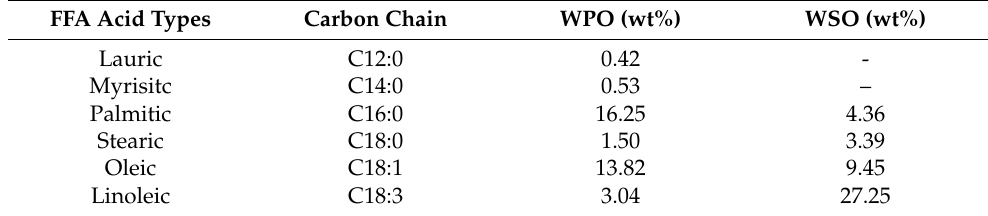
Table 3. Fatty Acids Compositions in waste cooking oils.